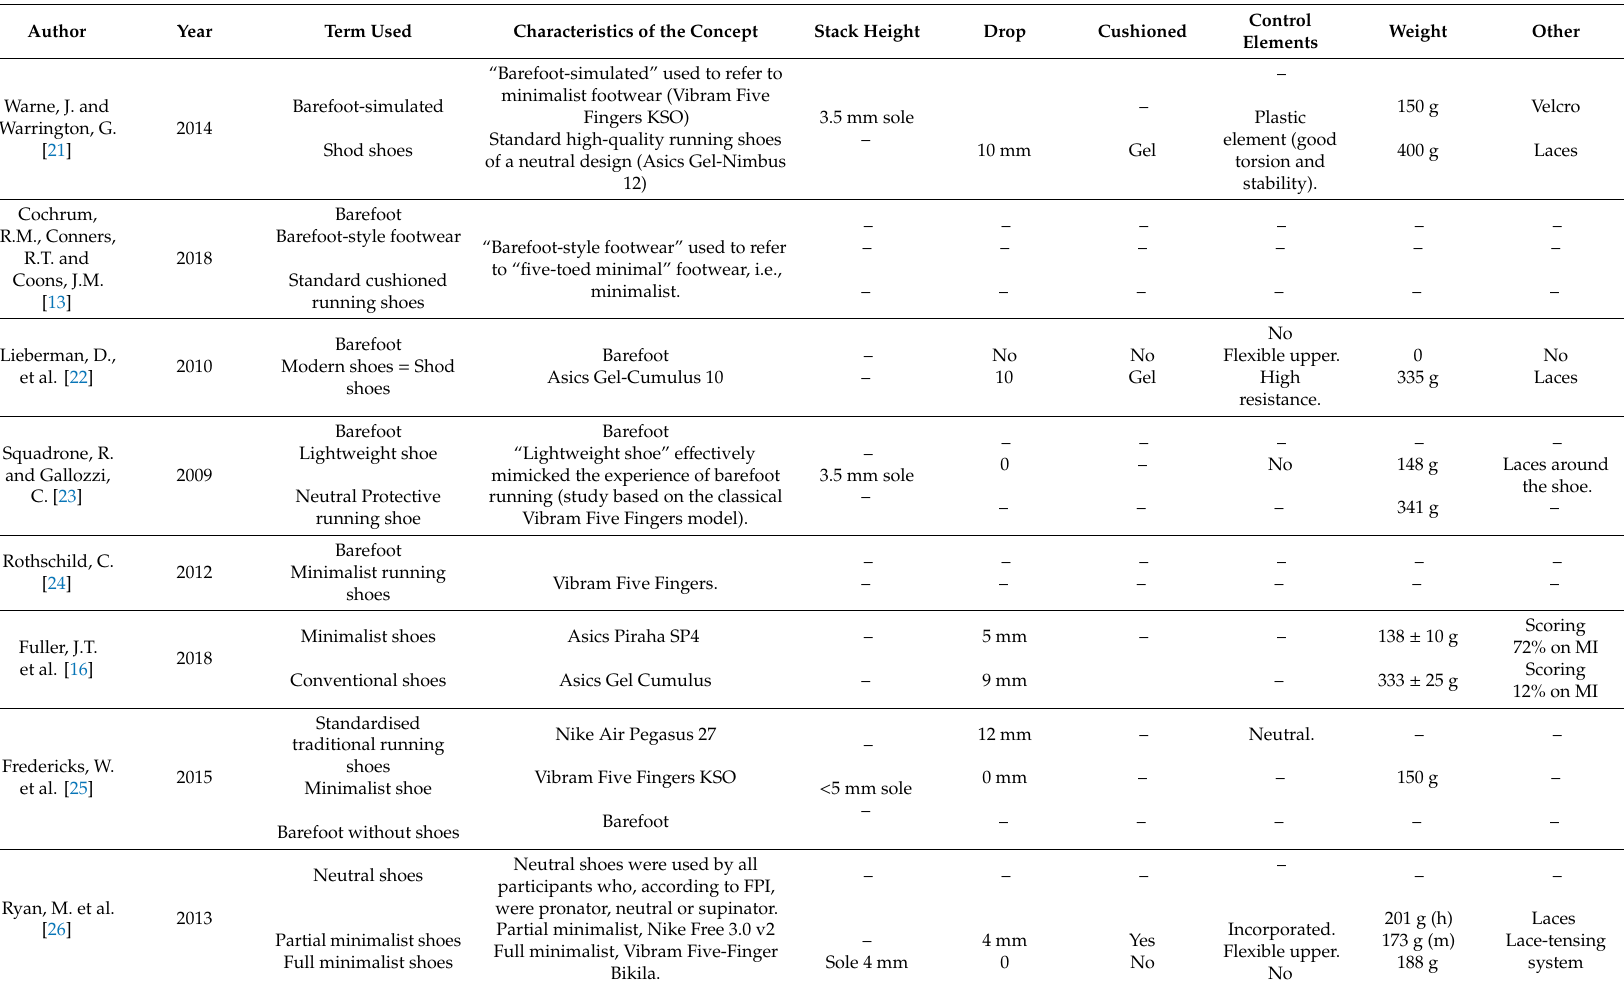
Table 1. Summary of the studies examined to extract the terms used for running